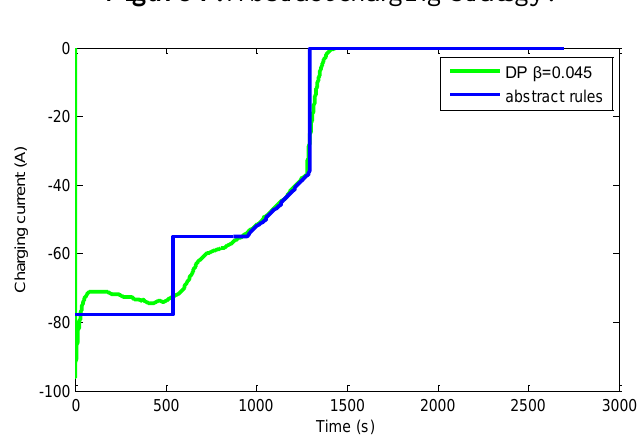
Figure 7. Abstract charging strategy.